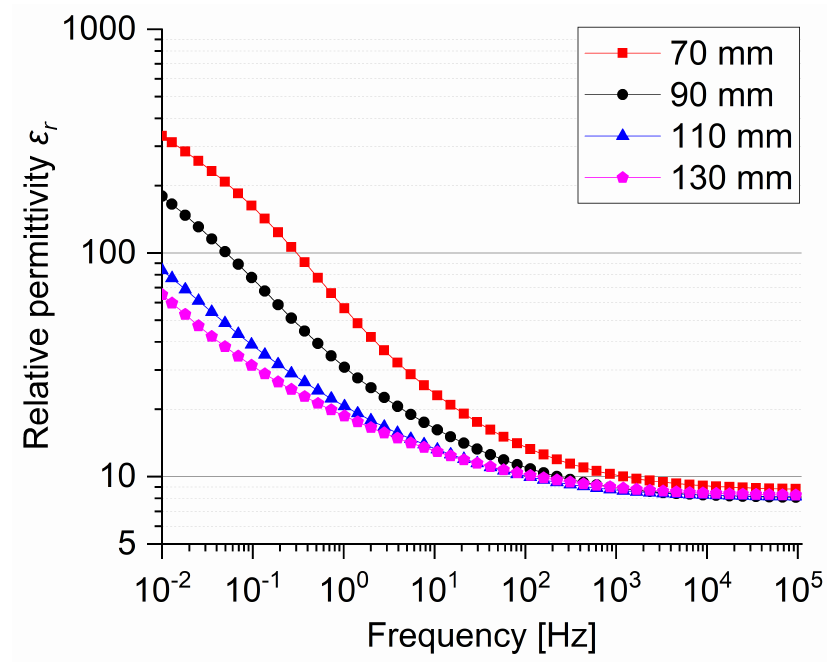
Figure 6. Relative permittivity of Al 2 O 3 coatings as a function of